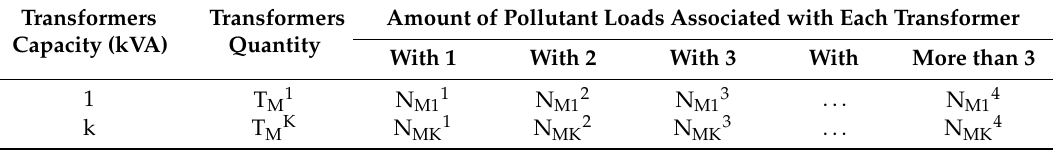
Table 2. Representative sample of the total population of transformers with new types of pollutant loads. Transformers Transformers Amount of Pollutant Loads Associated with Each Transformer Capacity (kVA) Quantity With 1 With 2 With 3 With More than 3